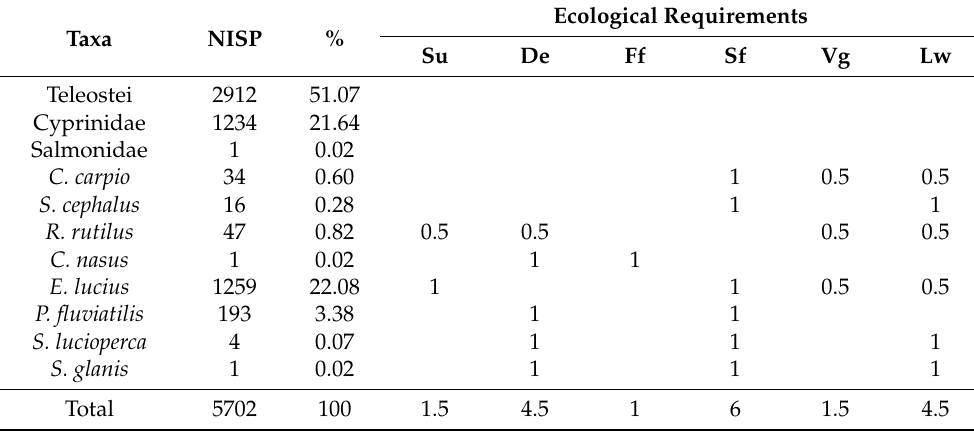
Table 8. Scores attributed to each key fish species found at Borsodiv á nka during the 2020 campaign according to its ecological requirements, used for the modified habitat weighting method: surface waters (Su), deep waters (De), fast-flowing waters (Ff), slow-flowing waters (Sf), vegetation ground (Vg), and large water sources (Lw). Ecological Requirements Taxa NISP % Su De Ff Sf Vg Lw Teleostei 2912 51.07 Cyprinidae 1234 21.64 Salmonidae 1 0.02